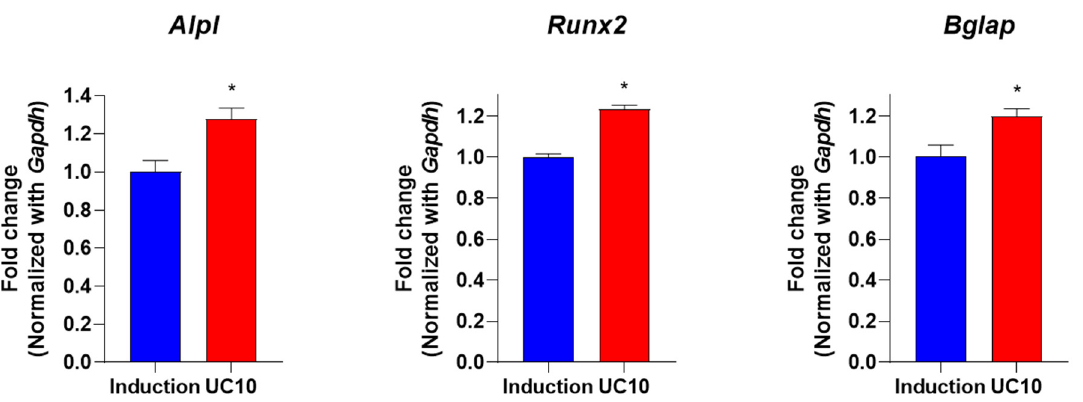
Figure 3. Osteogenic effects of UC extract on osteoblastogensis-related genes in primary osteoblasts. Mouse primary osteoblasts were co-incubated with an osteoblast induction medium and UC 5:5 extract (10 μ g/mL). After 3 days, the osteoblastogenesis-related genes such as mouse Alpl , Runx2 and Bglap were evaluated by qRT-PCR. The samples were determined by triplicate. UC, Ulmus davidiana (UD) and Cornus officinalis (CO) 5:5 ratio treatment; * p < 0.05 vs. induction (Student’s t -test).